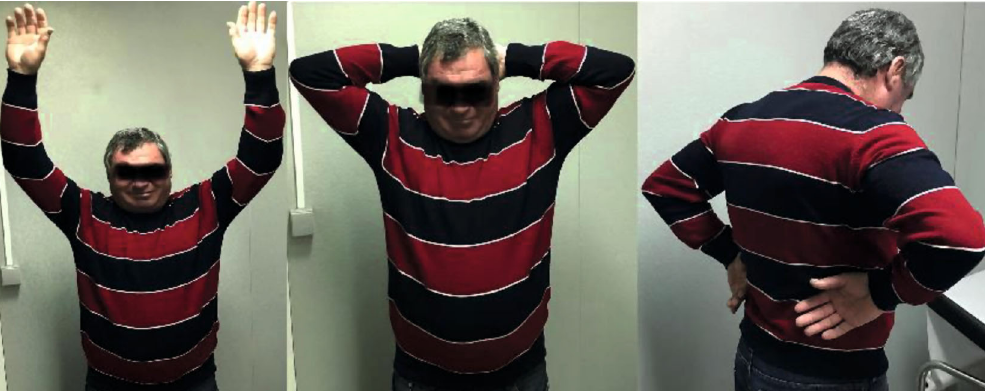
Figure 2: Functional outcomes three years after shoulder pyrocarbon